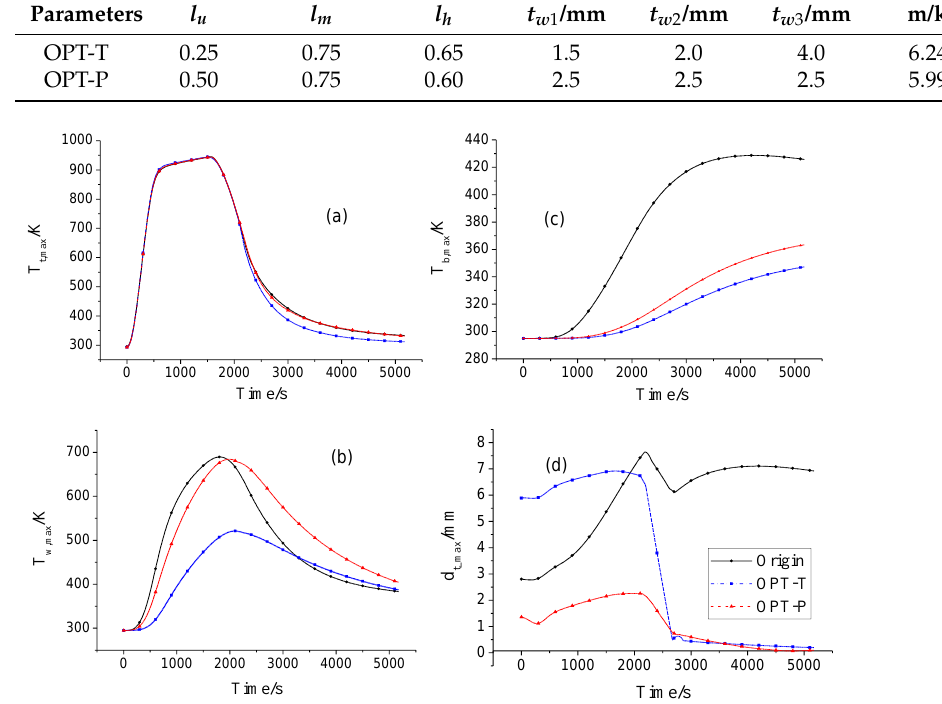
Figure 10. Thermal and mechanical response of the origin and optimized design. ( a ) Maximum temperatures of the TFSs, ( b ) maximum temperatures of the mid-points of the webs, ( c ) maximum tempertures of the BFSs and ( d ) maximum displacements of the TFSs.